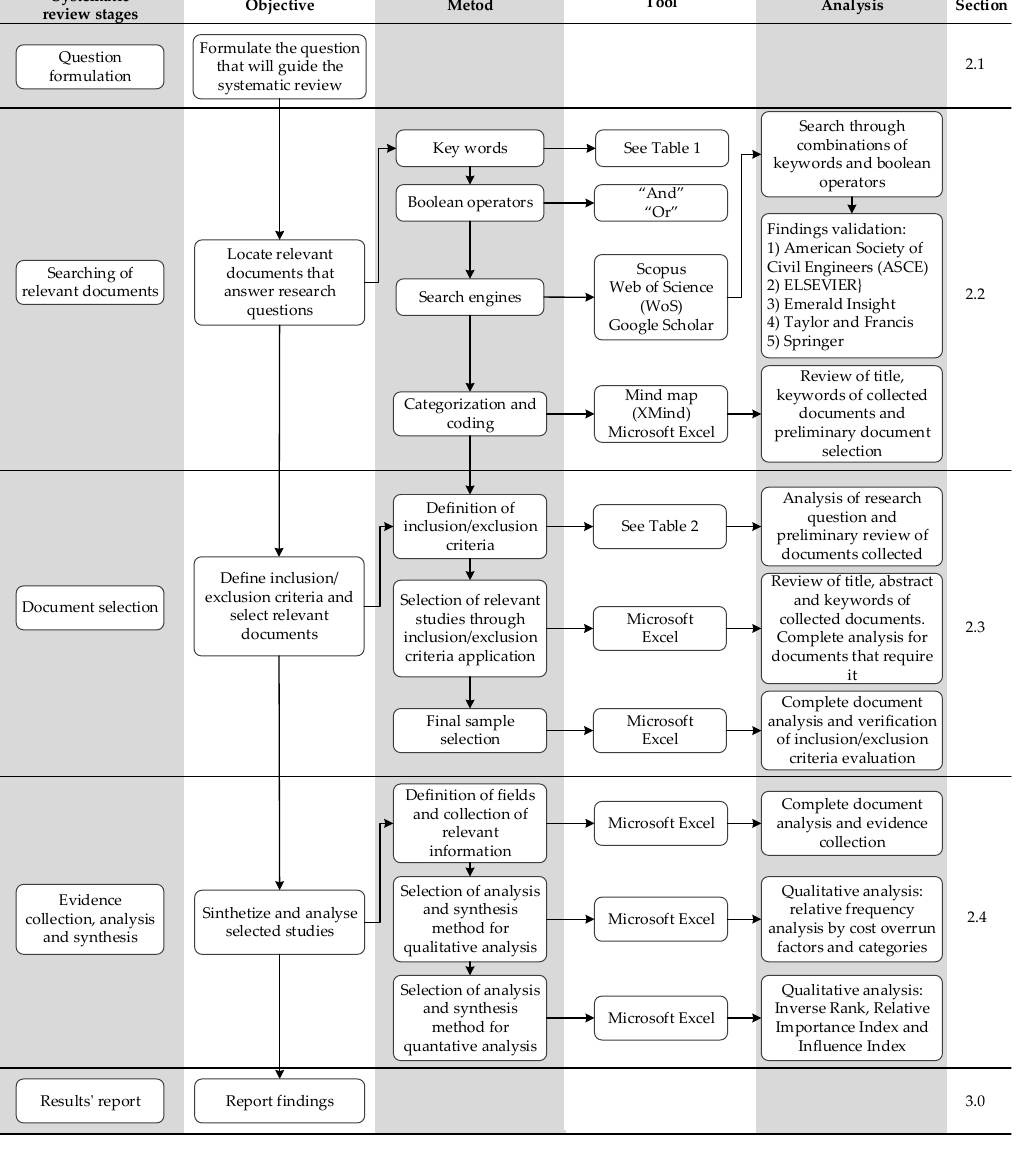
Figure 1. Systematic review stages, an adaptation of the method exposed by Saieg et al.